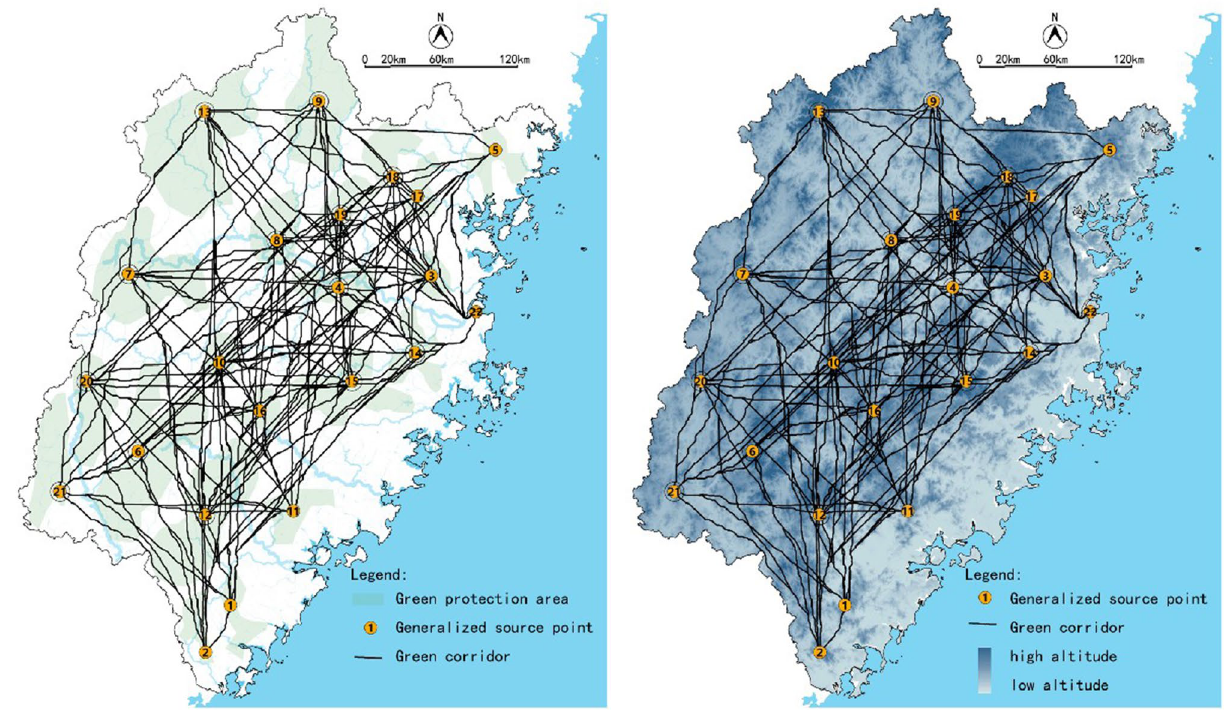
Figure 13. The green (minimum resistance) corridors of the Fujian